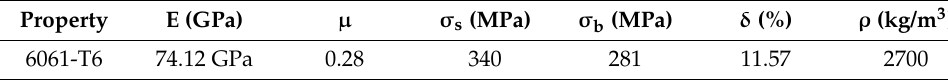
Table 4. Material properties of the T700/epoxy composite.